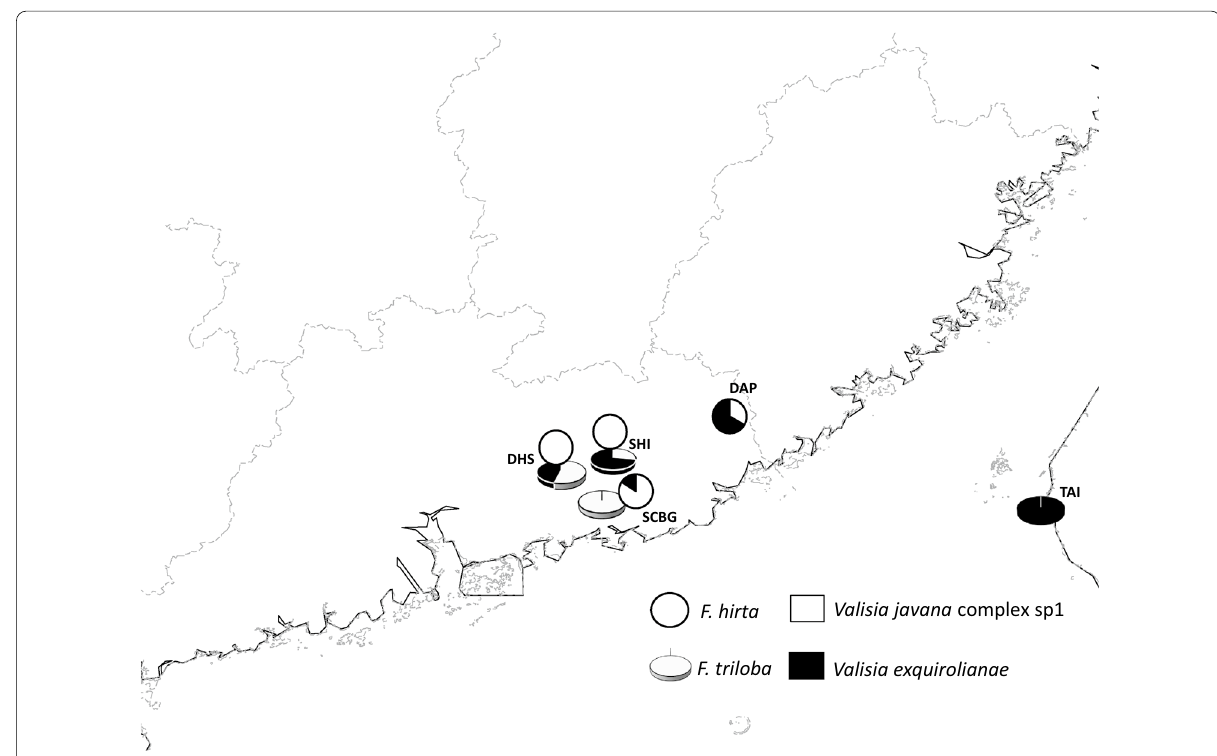
Fig. 1 Sample sites and distributions of the pollinator fig wasp species associated with Ficus hirta and F. triloba